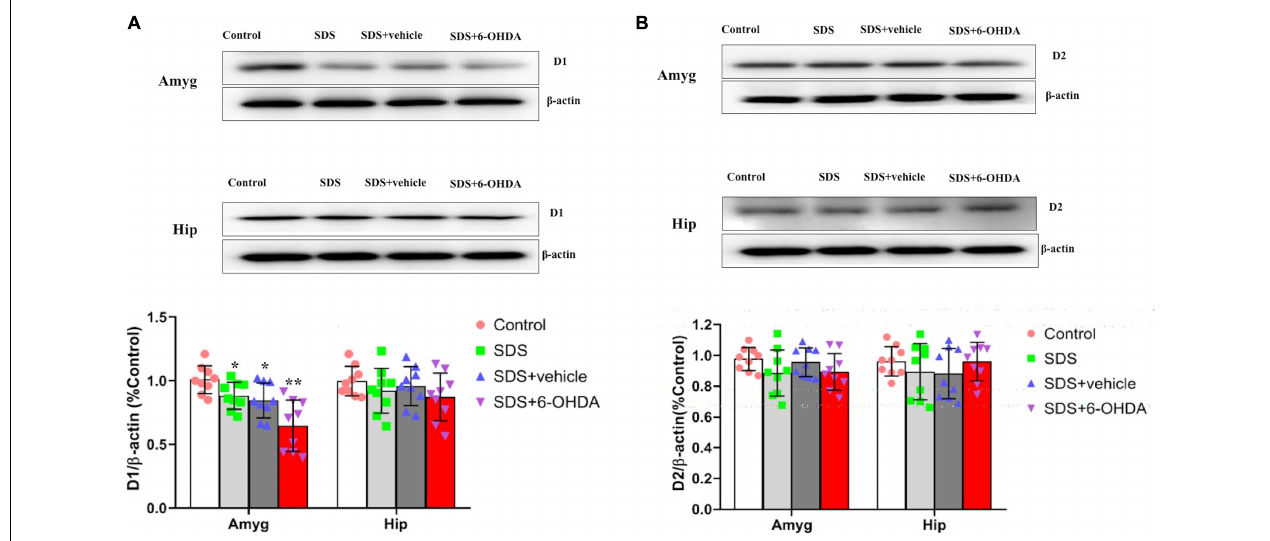
FIGURE 10 | Effects of social defeat stress on the expression of D1 (A) and D2 (B) in the amygdala and hippocampus on the 6-OHDA lesioned mice. * p < 0.05, ** p < 0.01, compared with the control group ( n = 9 per group).